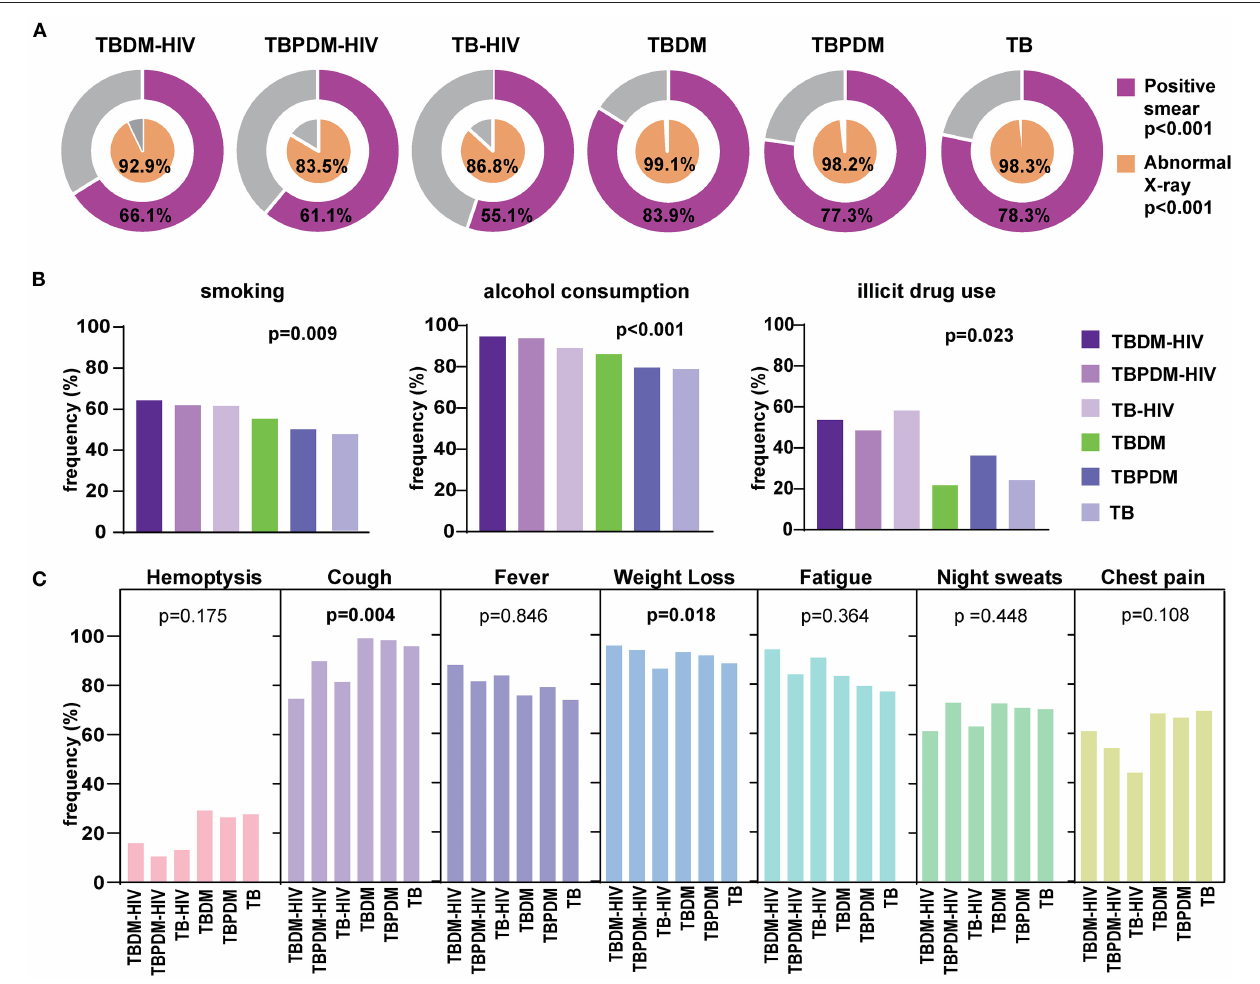
FIGURE 3 | Clinical Characteristics of people with TB according glycemic and HIV status in the RePORT-Brazil cohort. (A) Proportion of positive smears and abnormal X-rays in each study group. (B) Frequency of TB cases according glycemic and HIV status regarding smoking habit, alcohol consumption and illicit drug use (smoking, alcohol, and illicit drug: in the past or at the time of evaluation before anti-TB treatment). (C) Frequency of TB classical symptoms in each study group. The data were compared between the groups using the Pearson’s chi-square test. Comparisons with significant p-values are displayed in bold. TB, tuberculosis; DM, diabetes; PDM,